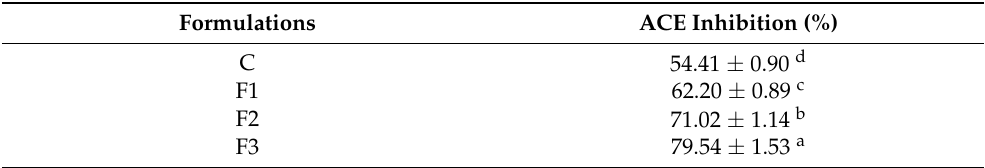
Table 4. Inhibitory effects of control and GABA-enriched dark chocolates on angiotensin-converting enzyme (ACE).